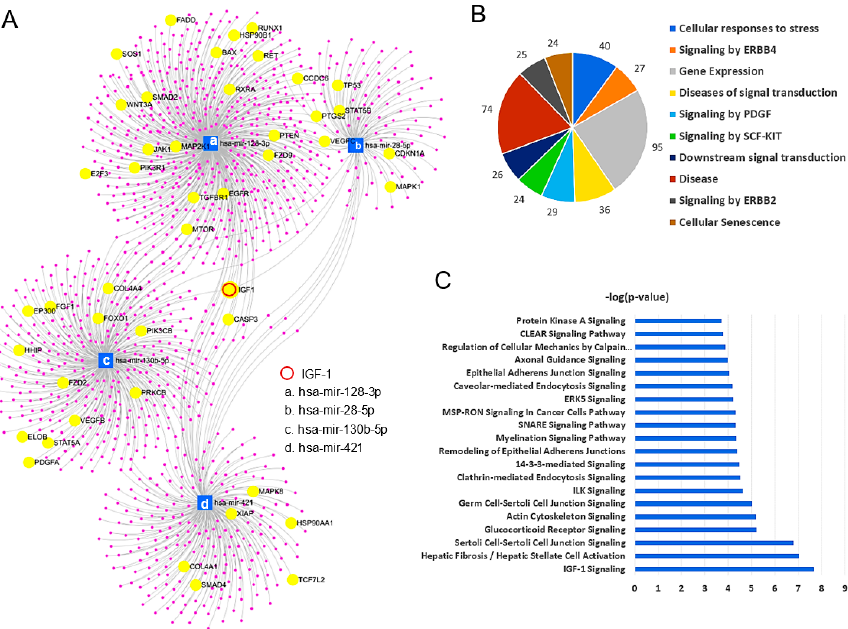
Figure 3. Functional Analysis. ( A ) Network diagram associated with target genes of four miRNAs. Highlighted were 45 target genes associated with Pathways in cancer. ( B ) Roles of top 10 target genes detected from the network analysis. ( C ) Canonical pathways significantly enriched in early-stage cancer with respect to high-risk benign from the proteomic study.